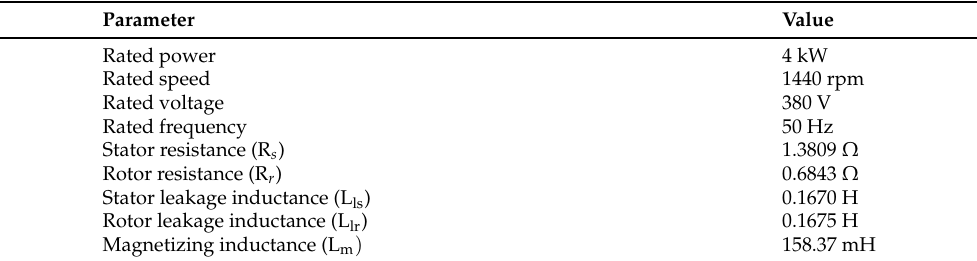
Table 3. Induction motor